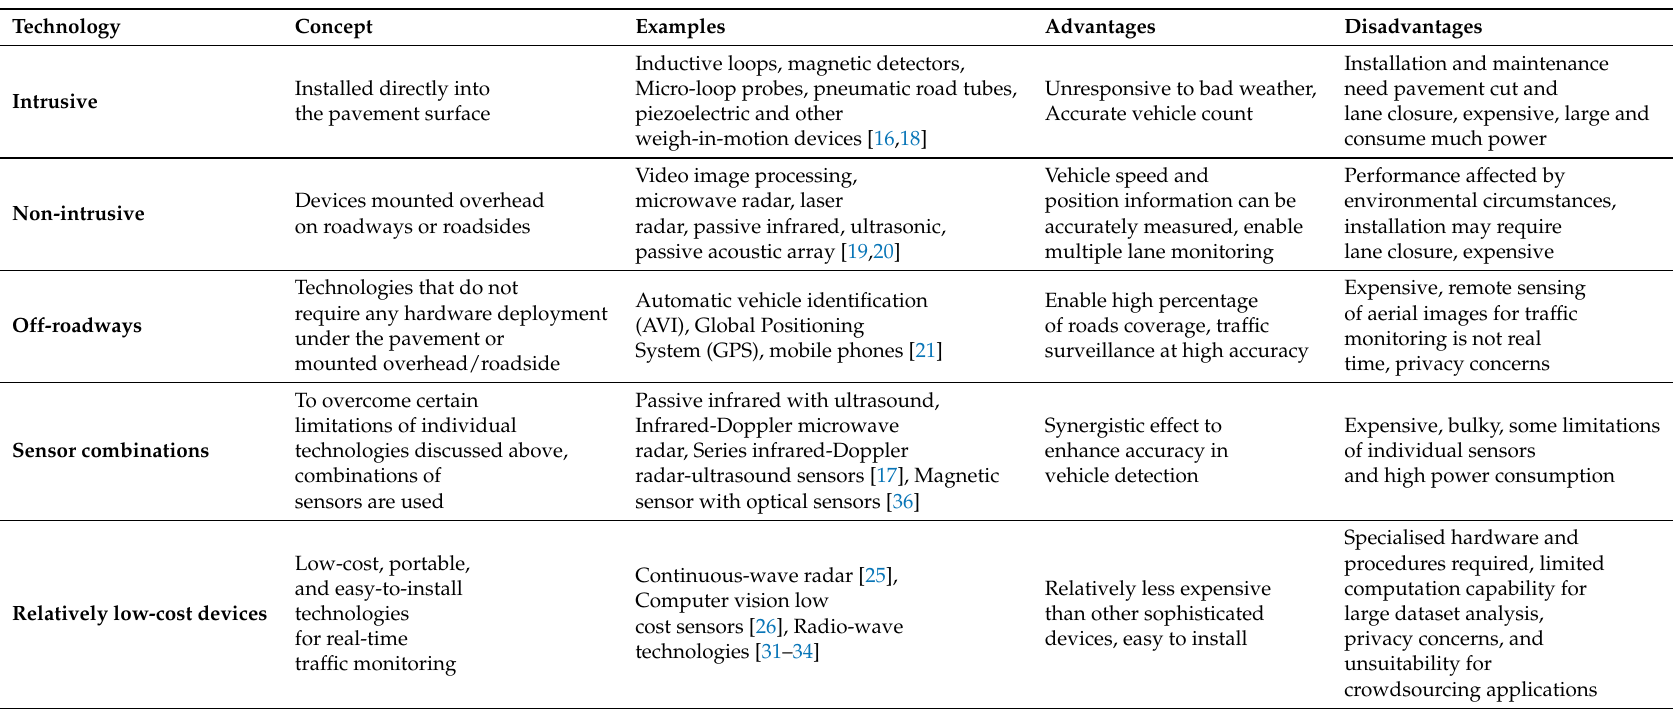
Table 1. Overview of various traffic monitoring